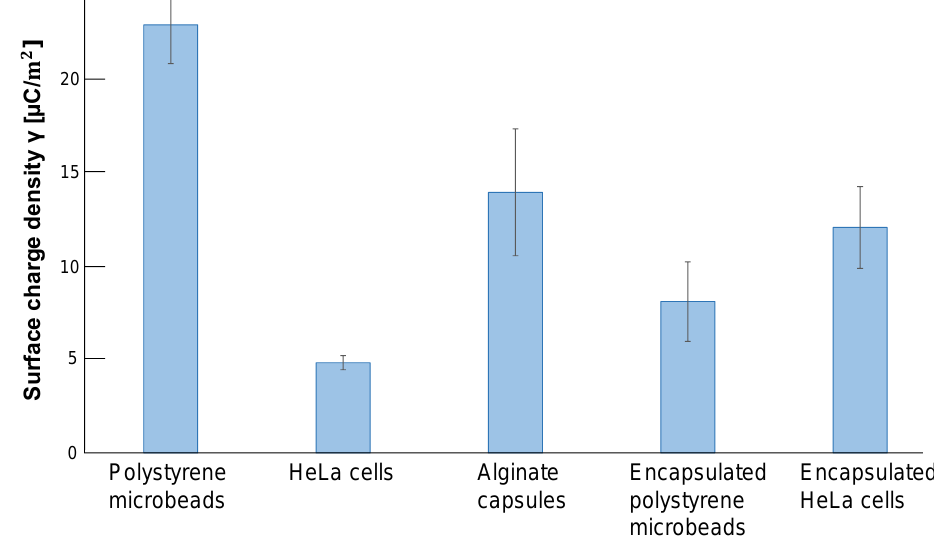
Figure 10. Surface charge densities of samples estimated by the slope of AC voltage and oscilla- tion amplitude relationship. Surface charge density of 10µm polystyrene microbeads, HeLa cells, empty alginate microcapsules, 10µm polystyrene microbead-encapsulated alginate microcapsules and HeLa cell-encapsulated alginate microcapsules. Error bars, SD (n = 3). One possible reason for charge density reduction might be the interference of the thin alginate gel layer to reduce the thickness of the electric bilayer formed on the surface of polystyrene spheres. In contrast, the increase of the surface charge of HeLa cells